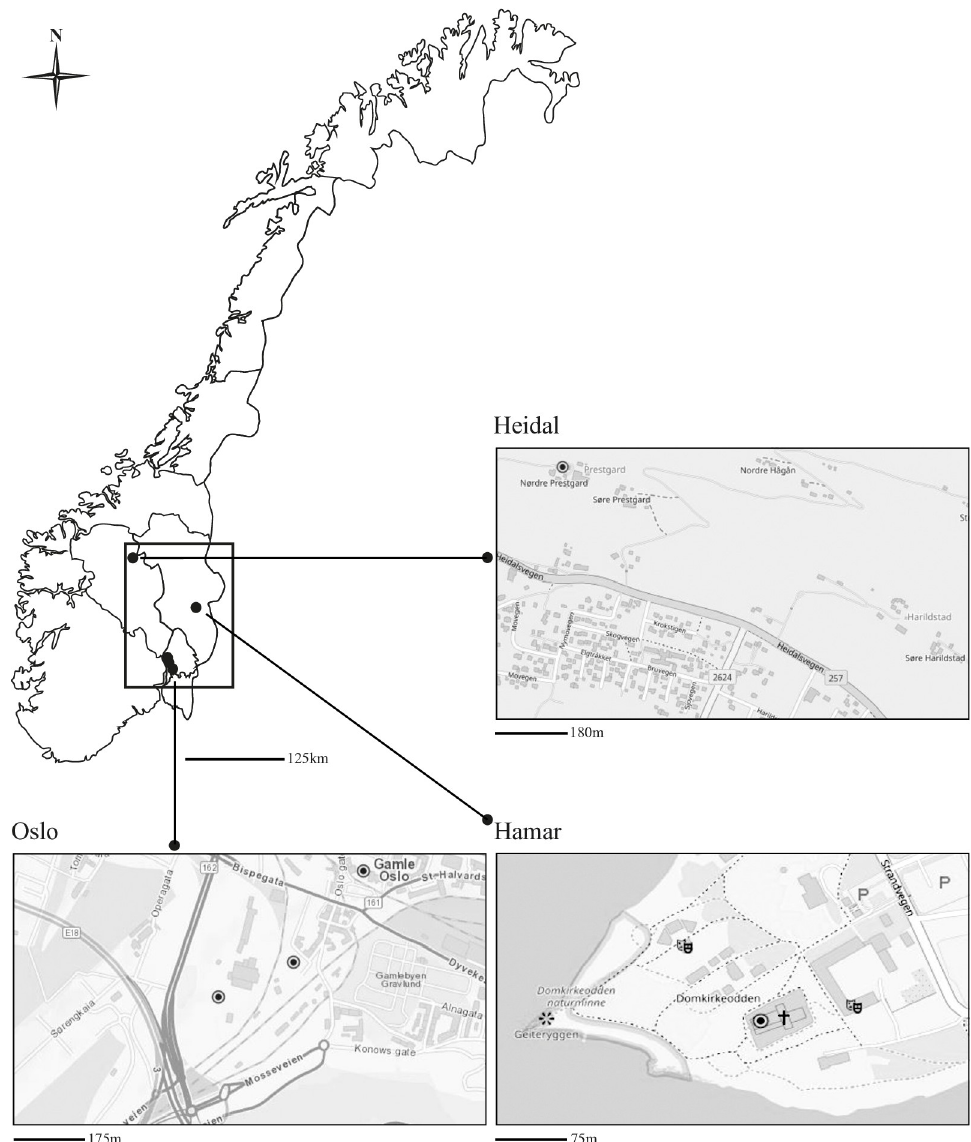
Fig 1. Map showing the location of the five burial sites included in the study. 1. Church of St. Mary (ca. 1050–1540 AD); 2. Church of St. Clemens (980–1030 AD); 3. St. Olav’s Monastery (1239–1537 AD); 4. Church of Prestgard (early 11th century-1531 AD); 5. Hamar Cathedral (early 12th 77 century-1565/1570 AD). Figure created with map data from U.S. Geological Survey.